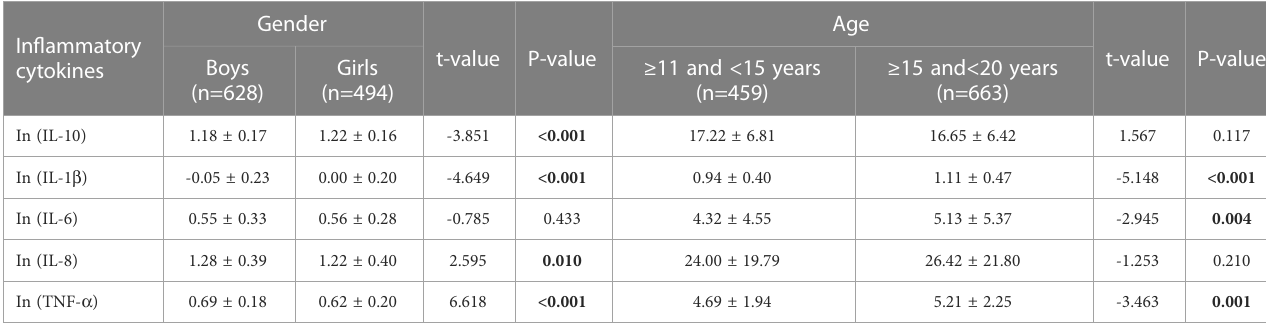
TABLE 2 In fl ammatory cytokine characteristics by gender and age.